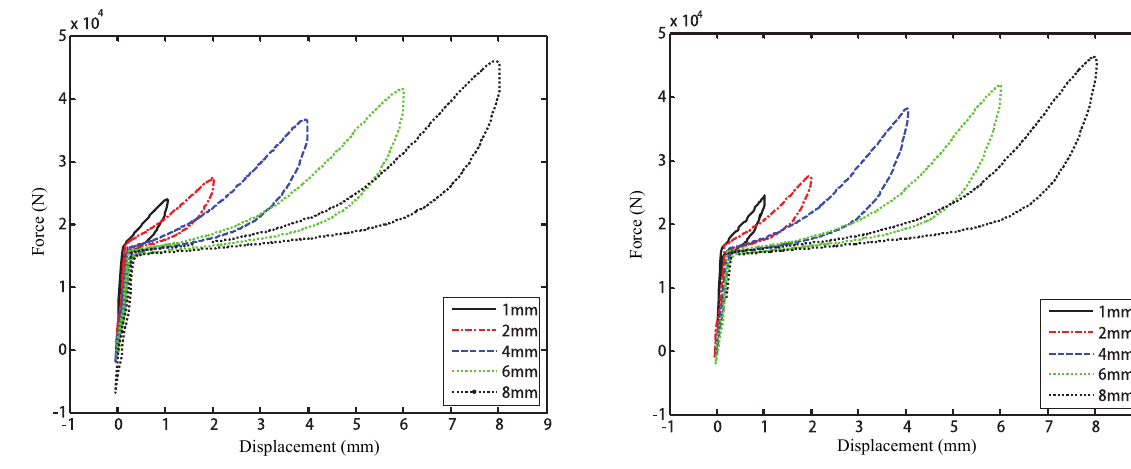
Fig. 6. Hysteresis curves under 0.2 Hz with various amplitudes exci- tations.